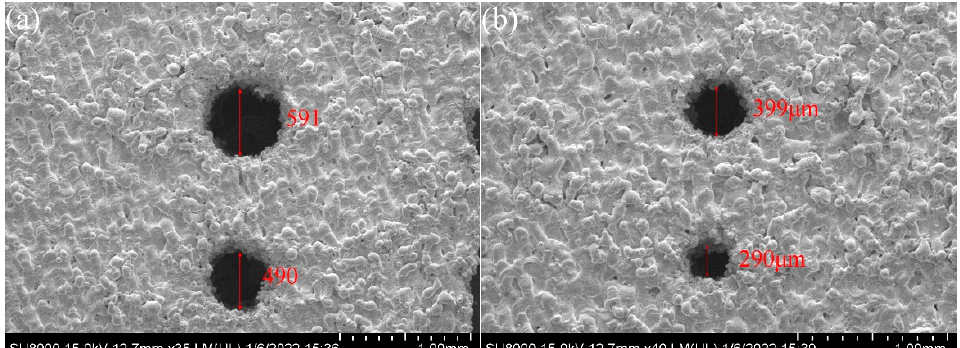
Figure 14. Cloud map of roughness distribution of double-layer reflow microchannel.